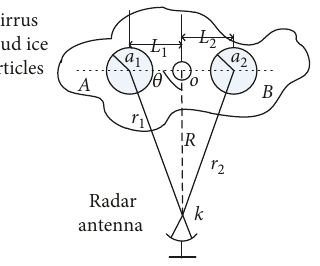
Figure 1: The geometric relationship between two particles and radar antenna.